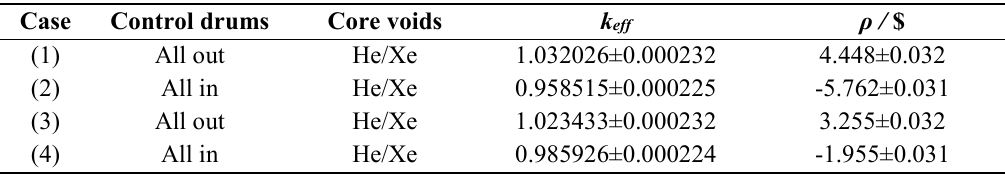
Table II. Reactivity results in different